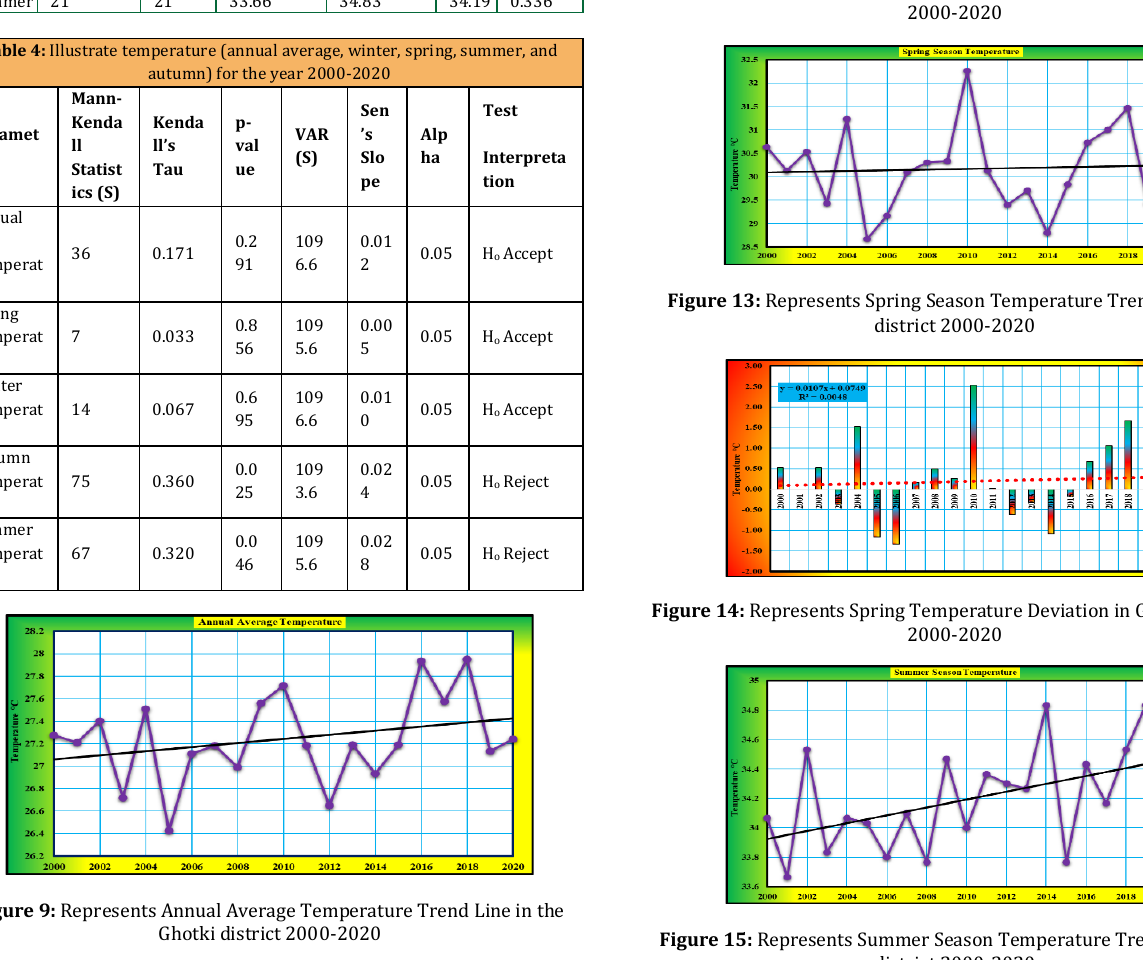
Figure 12: Represents Winter Temperature Deviation in Ghotki district